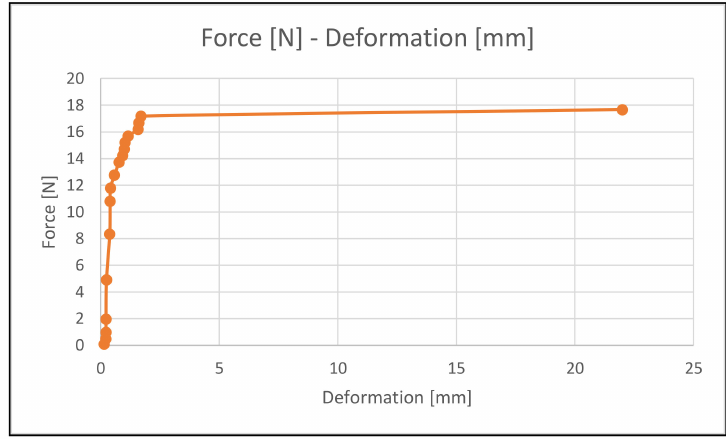
Figure 13. Microstructure Force-Deformation curve.